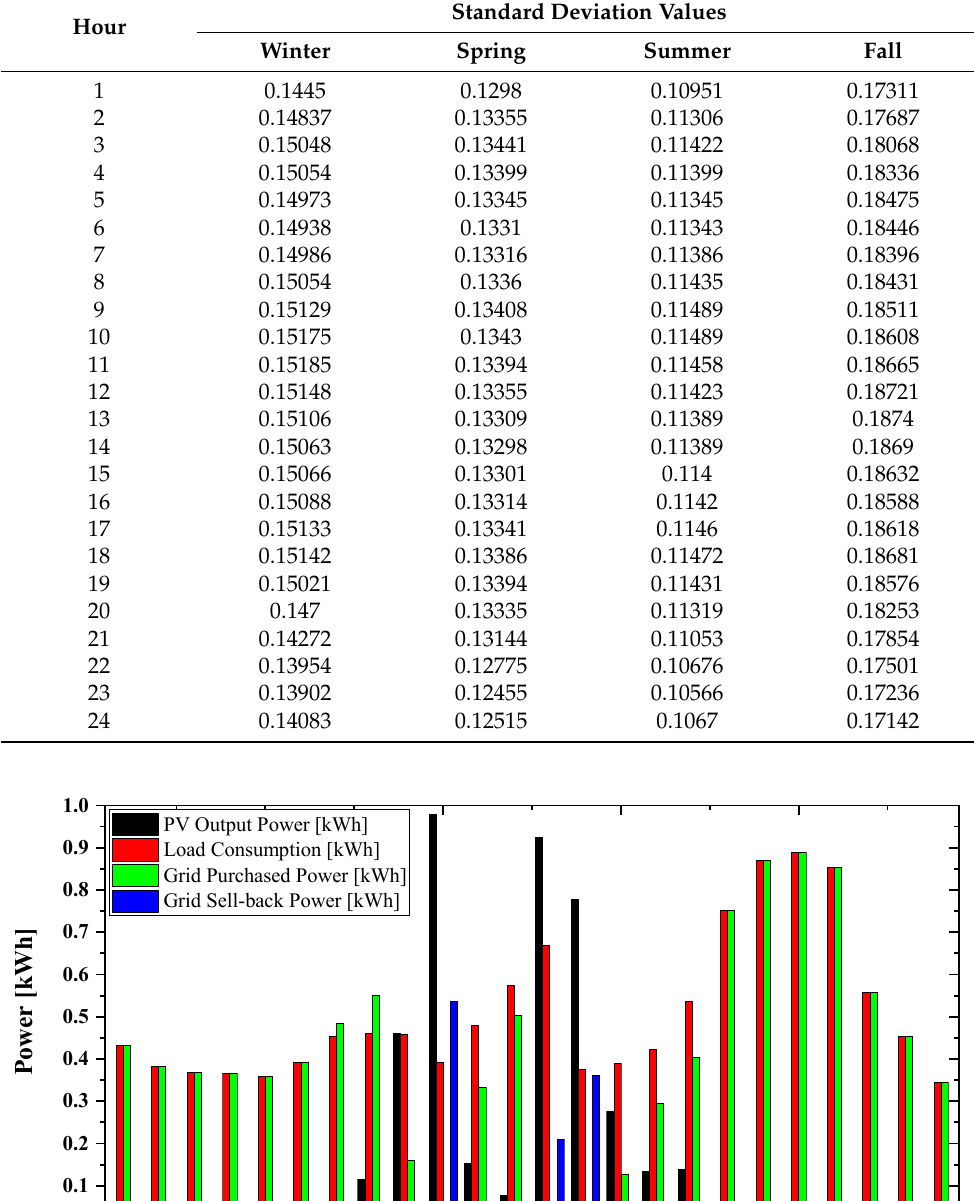
Table 6. Standard deviation of load demand for different seasons before DR program implementation.